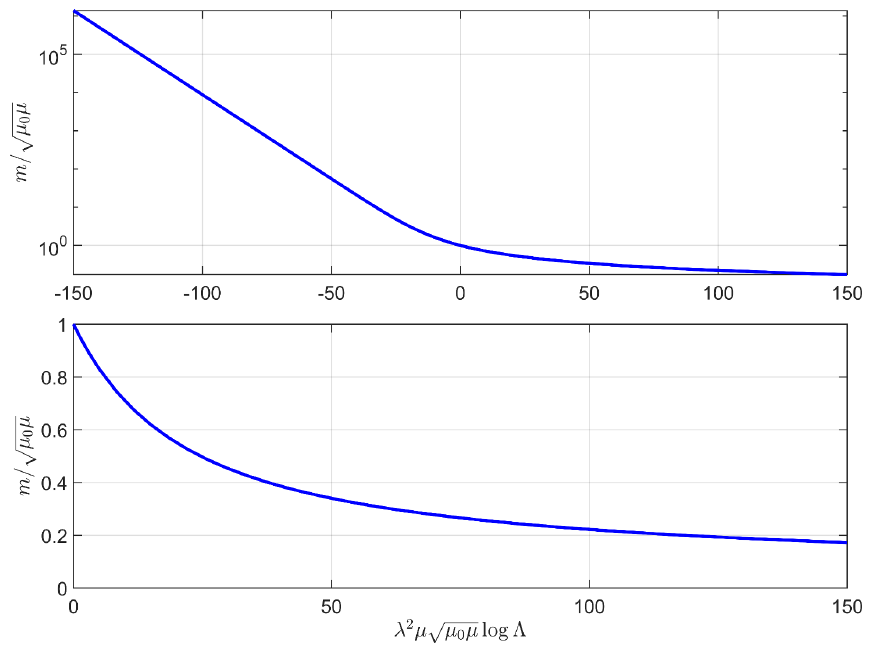
Figure 1 . New RG flow of the fermion mass m